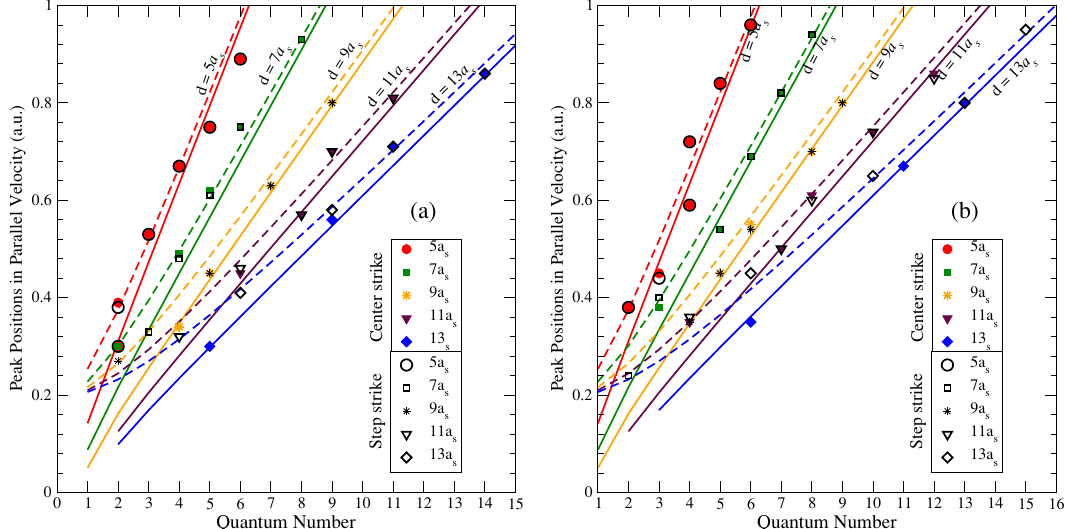
Figure 9. Comparison of the ion survival peak positions in the parallel velocity scale for various values of vicinal step separation d on Cu(111) with an analytic square well potential model, using the energy of the first (solid line) and second (dashed line) image state, and for the BZ trajectory ( a ) and the BSL trajectory ( b